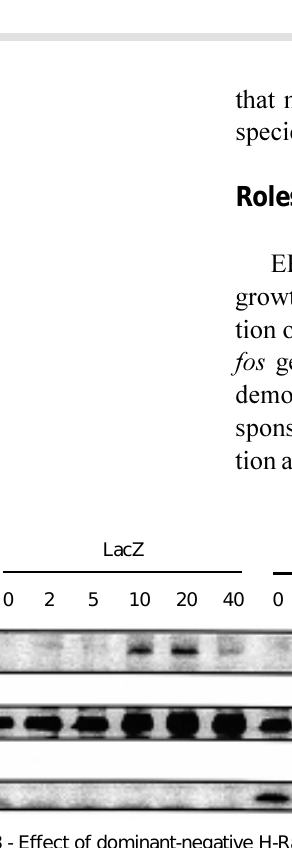
Figure 3 - Effect of dominant-negative H-Ras transfection of angiotensin II (Ang II)-induced Ser 411 phosphorylation (S 411 P) of p70 S6k . VSMC were transfected with AdRas Y 57 or control AdLacZ as indicated before stimulation. Cells were stimulated with Ang II (100 nM) for indicated durations. Cell lysates were analyzed by immunoblotting (IB) with anti- [phospho-Ser 411 ]-p70 S6k , anti-p70 S6k , and anti-H-Ras antibodies as indicated by repeated reprobing.